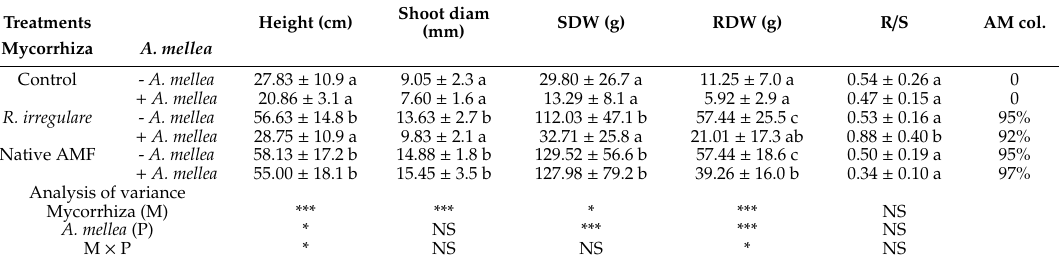
Table 2. Growth of the Eriobotrya japonica plants (height, shoot diameter (diam), shoot dry weight (SDW), root dry weight (RDW), root / shoot (R / S) dry weight) and percentage of arbuscular mycorrhizal root colonization (AM col.) with and without Rhizoglomus irregulare, or the native AMF, infected or not by Armillaria mellea